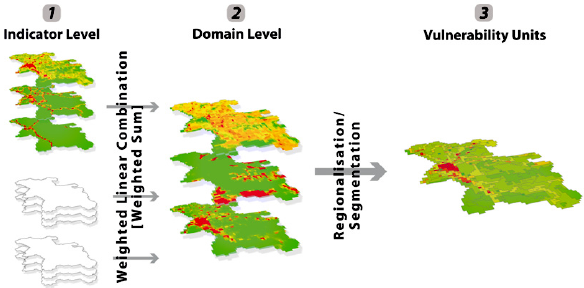
Figure 4. Workflow developed to model spatial vulnerability units in the Salzach River catchment (Kienberger et al., 2009).